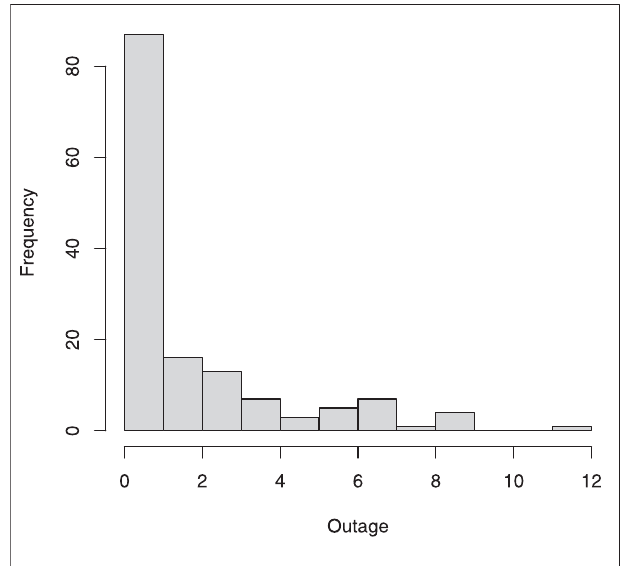
FIGURE 1 | Histogram of the vegetation-caused outages on each